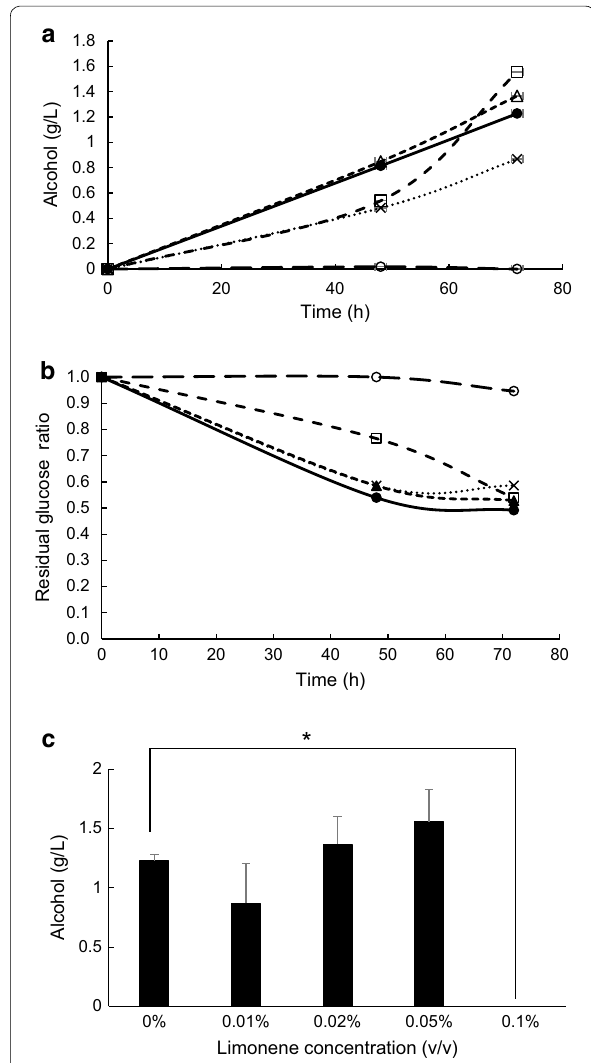
Fig. 3 Concentration of alcohol ( a ) and residual glucose ratio Fig. 2 Concentration of ethanol ( a ) and residual glucose ratio ( b ) in ( b ) in the culture medium with C. beijerinckii , where different the culture medium with S. cerevisiae , where different concentrations concentrations of limonene (v/v), 0% (filled circle), 0.01% ( ), of limonene (v/v), 0% (filled circle), 0.01% ( ), 0.02% (open triangle), × × 0.02% (open triangle), 0.05% (open square), and 0.1% (open circle), 0.05% (open square), and 0.1% (open circle), were present in the was present in the culture medium. c Alcohol production at 72-h culture medium. c Ethanol production at 48-h cultivation. Values are cultivation. Values are mean SE of three independent samples. An mean SE of three independent samples. An asterisk indicates a ± ± asterisk indicates a significant difference (p < significant difference (p < 0.05)